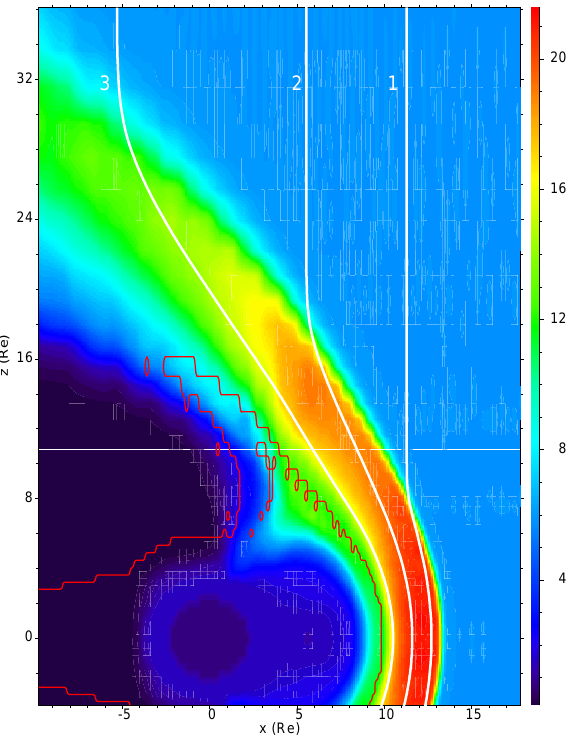
Fig. 13. Three field lines in the y =0 plane along which we choose to study the MHD forces. The open-closed magnetic field boundary is shown as a red zigzag curve and the plasma density is shown color coded as the background. From right to left the field lines are marked